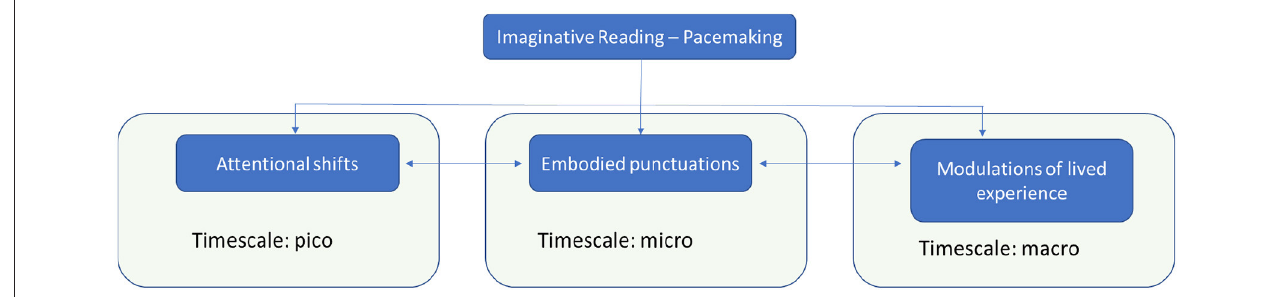
FIGURE 1 | Model of reading as a process unfolding at multiple intertwined timescales spanning pico, micro and macro behaviors. The model is elaborated further in Figure 6